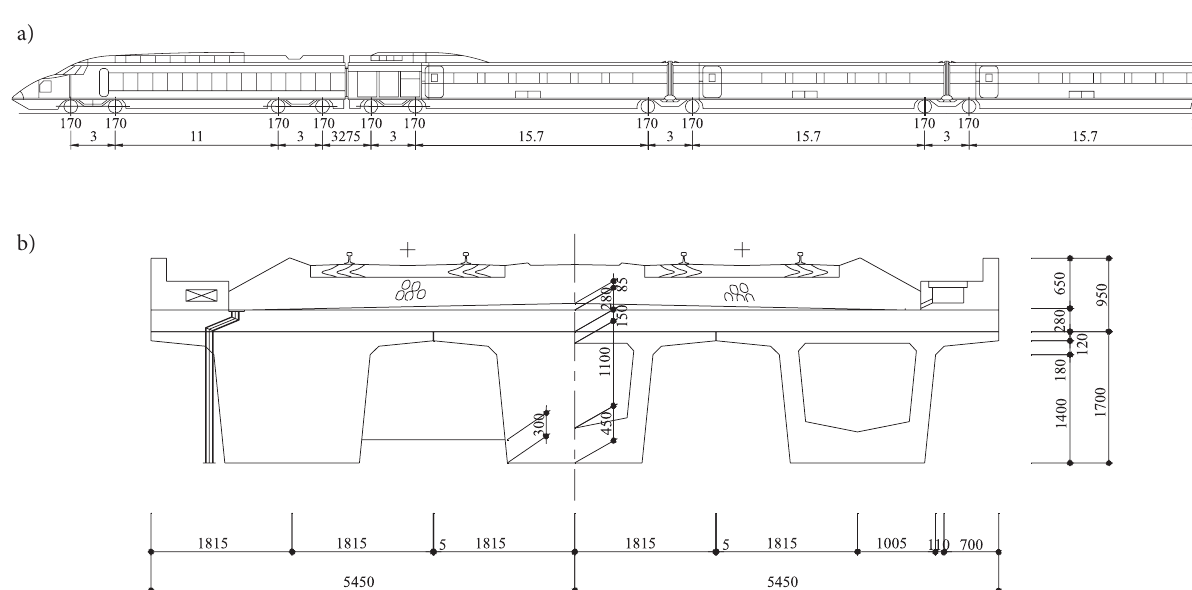
Fig. 6. Railway application: a – Korean Train eXpress (KTX) wheel loads, wheel-to-wheel distance (unit: kN, m), b – railway bridge model with slab & ballast: 30 m long span, doubly-laned rail system